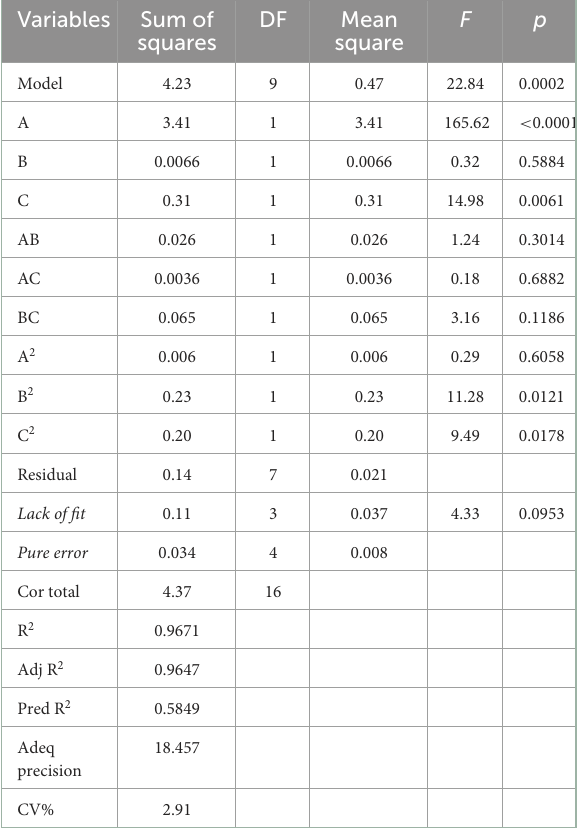
TABLE 1B ANOVA for response surface quadratic model.